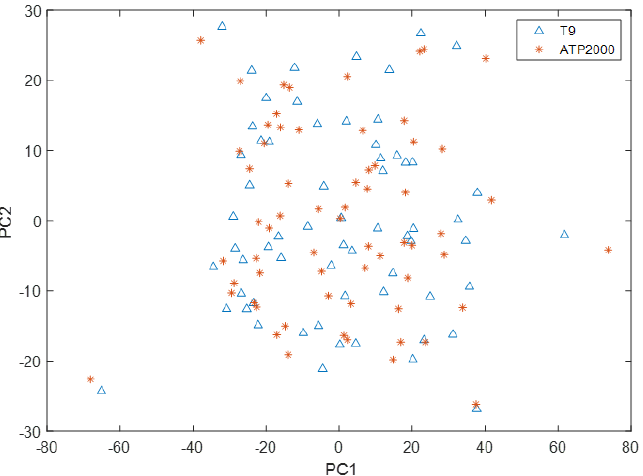
Figure 6. Spatial distribution of principal component scores of T9 and ATP2000